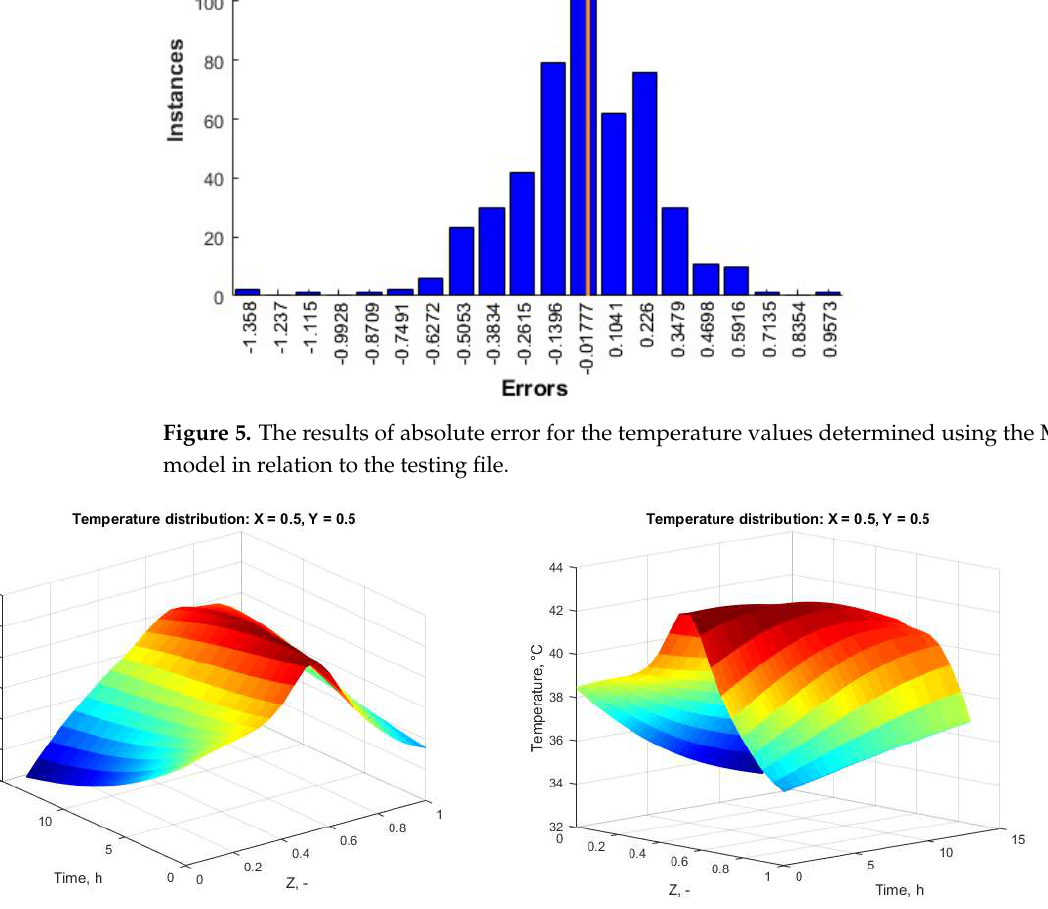
Figure 6. Temperature distribution in dimensionless function of deposit height and time for definite dimensionless value X = 0 and Y = 0 (according to Figure 2) obtained from the model MLP 4-7-1 network.